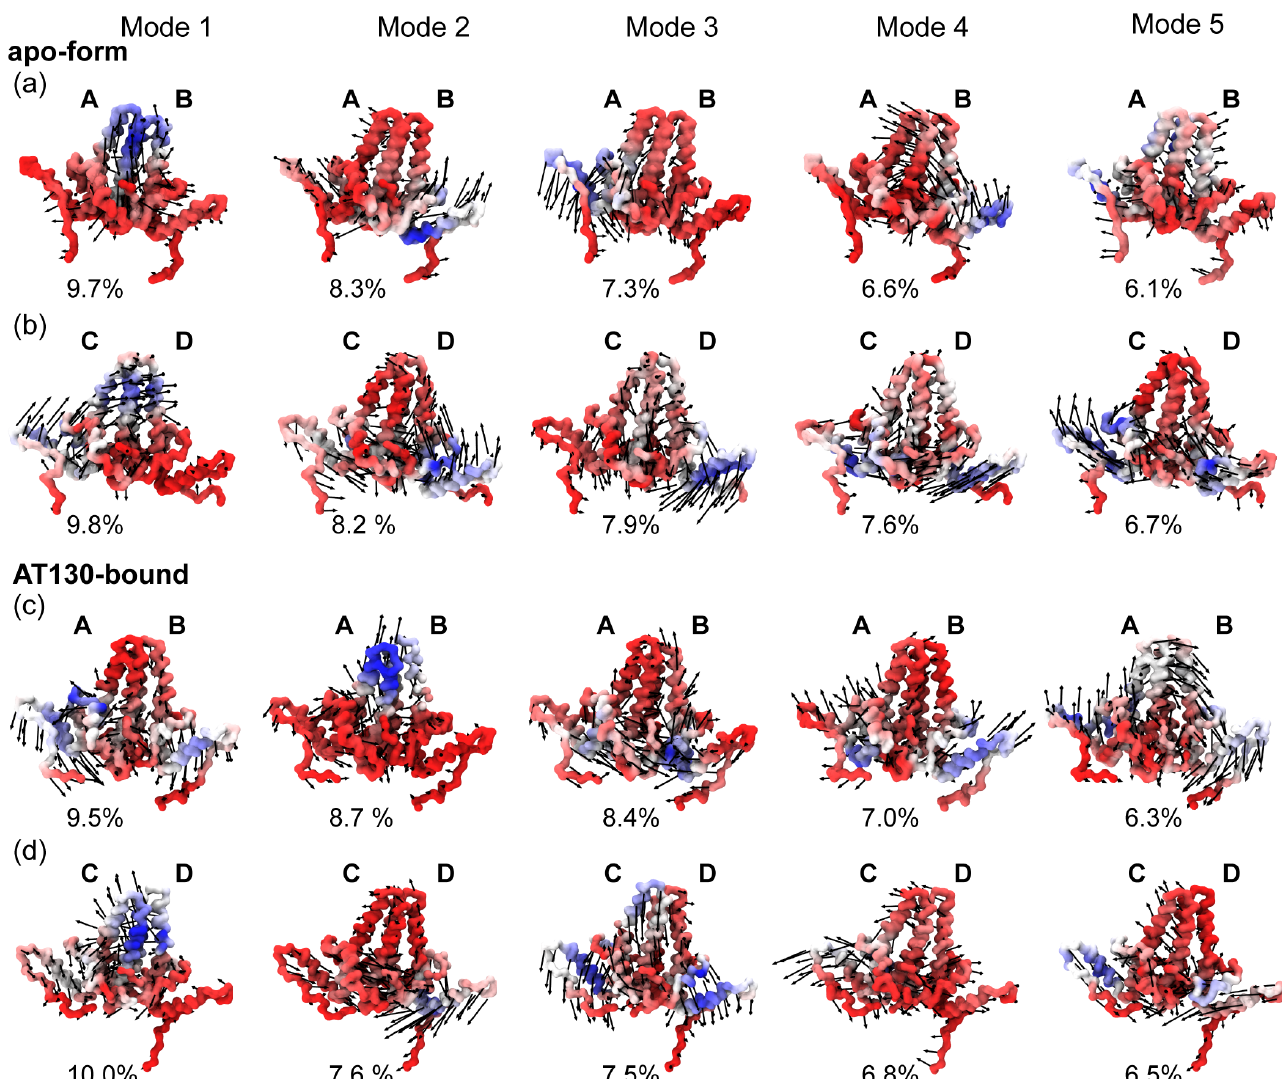
Figure 7. Essential dynamics of capsid-incorporated dimers. ( a ) Apo-form dimer AB. ( b ) Apo-form dimer CD. ( c ) AT130- bound dimer AB. ( d ) AT130-bound dimer CD. Backbone trace of dimers shown for each of the top five modes of essential dynamics, calculated based on principal component analysis of 60 µ s of cumulative simulation sampling. Blue to red color scale denotes high to low mobility. Black arrows indicate direction of motion and are scaled by 12 for visual clarity. Percentages indicate contributions to variance, which total 38.0%, 40.2%, 39.9%, and 38.4%, respectively for panels ( a – d